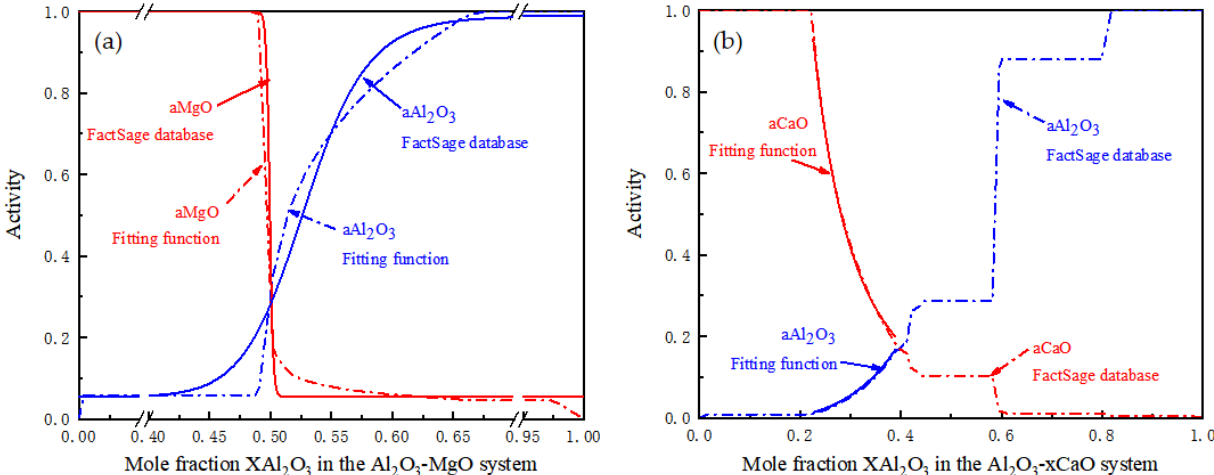
Figure 11. ( a ) Activities of Al 2 O 3 and MgO at different mole fractions of Al 2 O 3 in Al 2 O 3 –MgO system ( b ) Activities of Al 2 O 3 and CaO at different mole fractions of Al 2 O 3 in Al 2 O 3 –xCaO system.